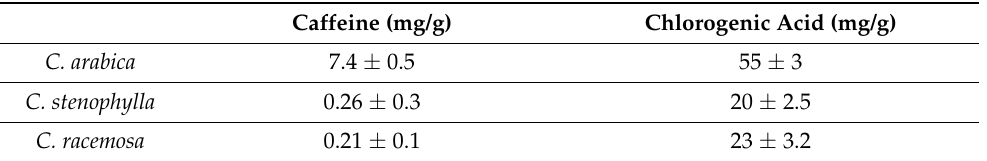
Table 1. Concentration of caffeine and chlorogenic acid in three Coffea species measured by HPLC. Values are described in milligrams of the compound per gram of